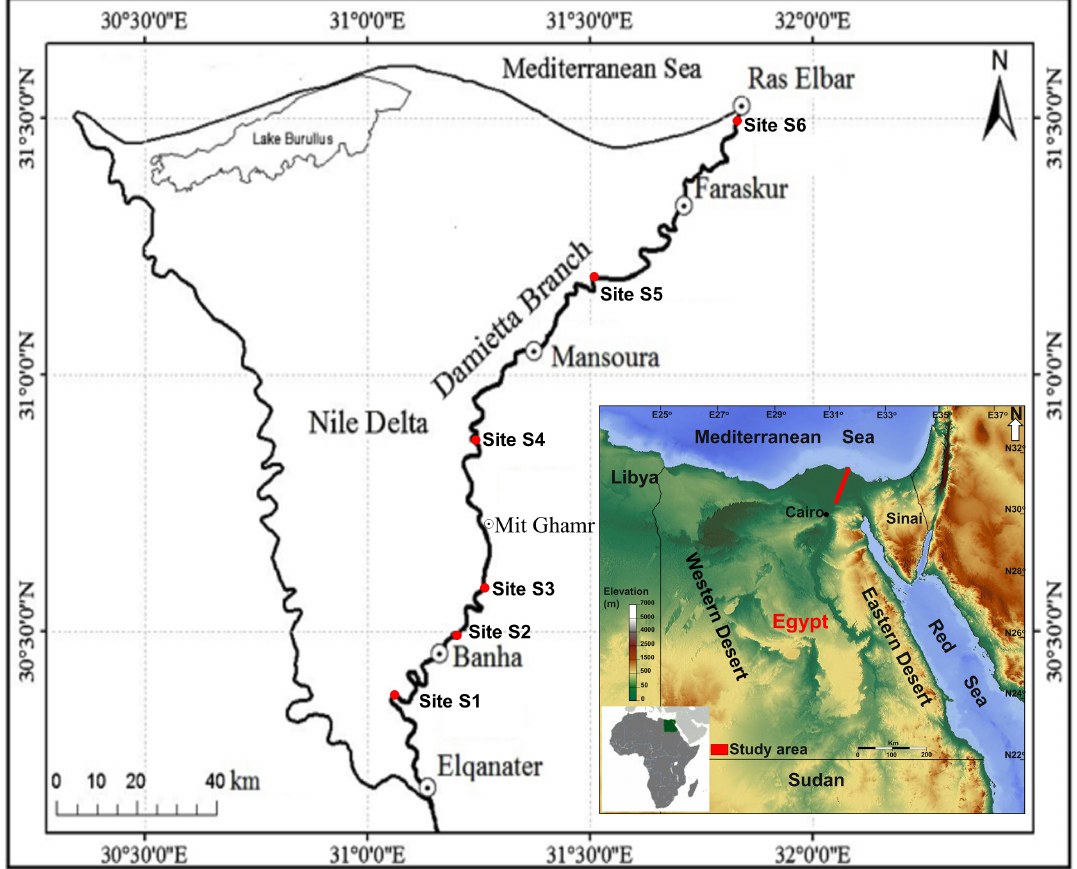
Figure 1. Map of Nile delta and different sampling sites along Damietta Nile River